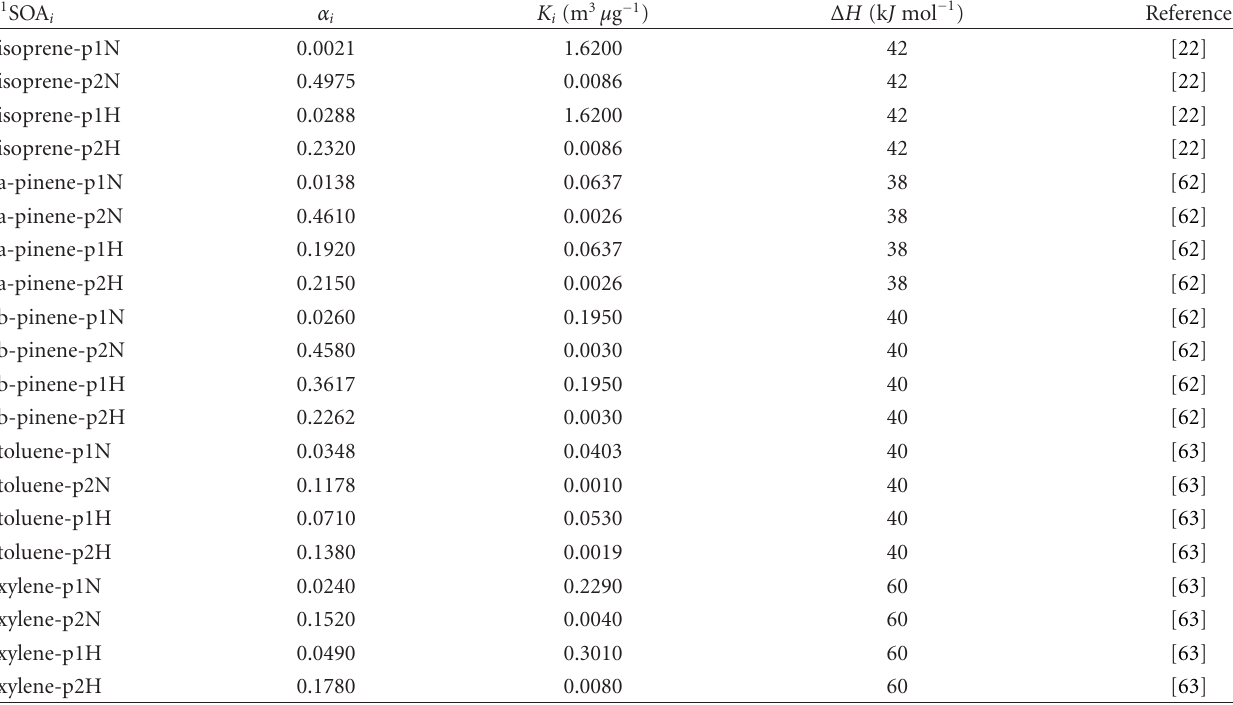
Table 3: Properties of the SOA species used by the two-product model for SOA